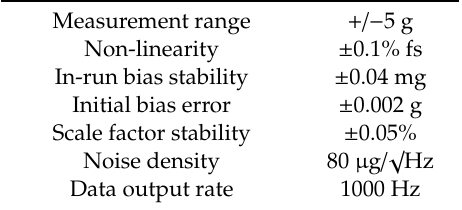
Figure 5. Block diagram of the measurement system. PSD: Spectral Power Density; FFT: Fast Fourier Transform. Table 2. Acceleration sensor type 3DM-GX3-25 specifications.